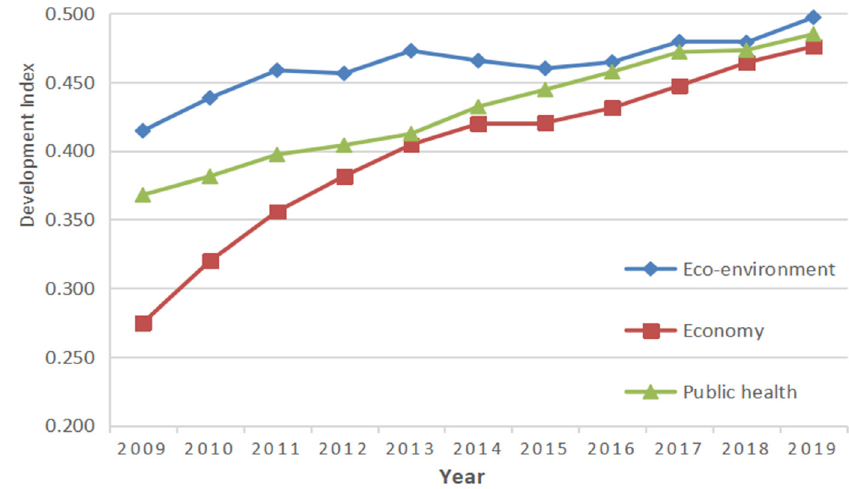
Figure 3. The overall subsystem development trend change diagram.